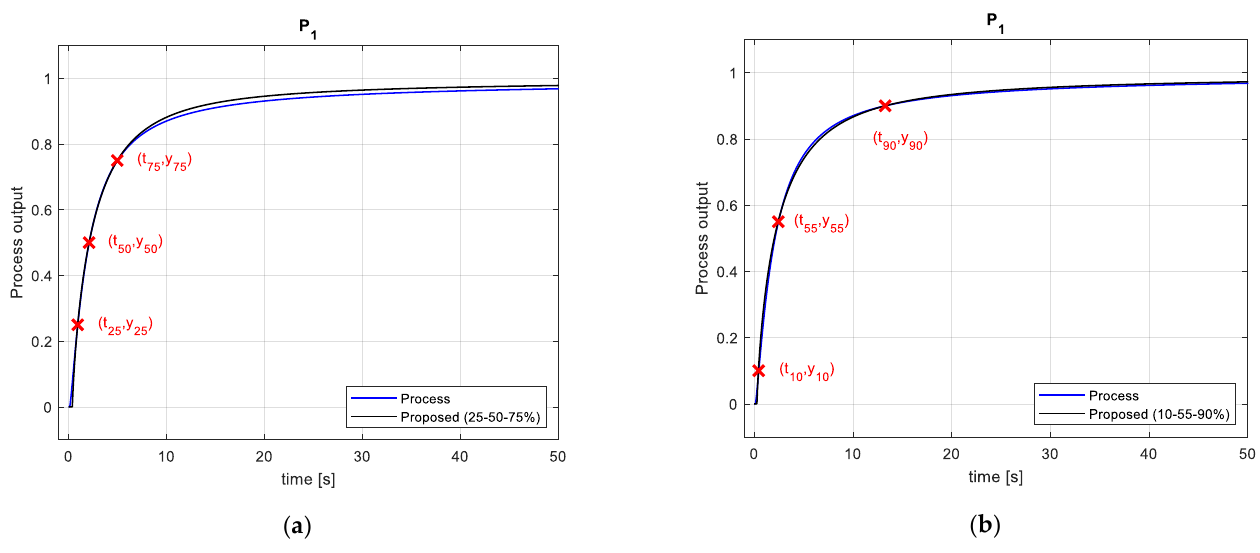
Figure 9. FFOPDT model step response using the proposed identification method for process P 1 and process reaction curve: ( a ) Symmetrical set of points (25-50-75%); ( b ) Asymmetrical set of points (10-55-90%).